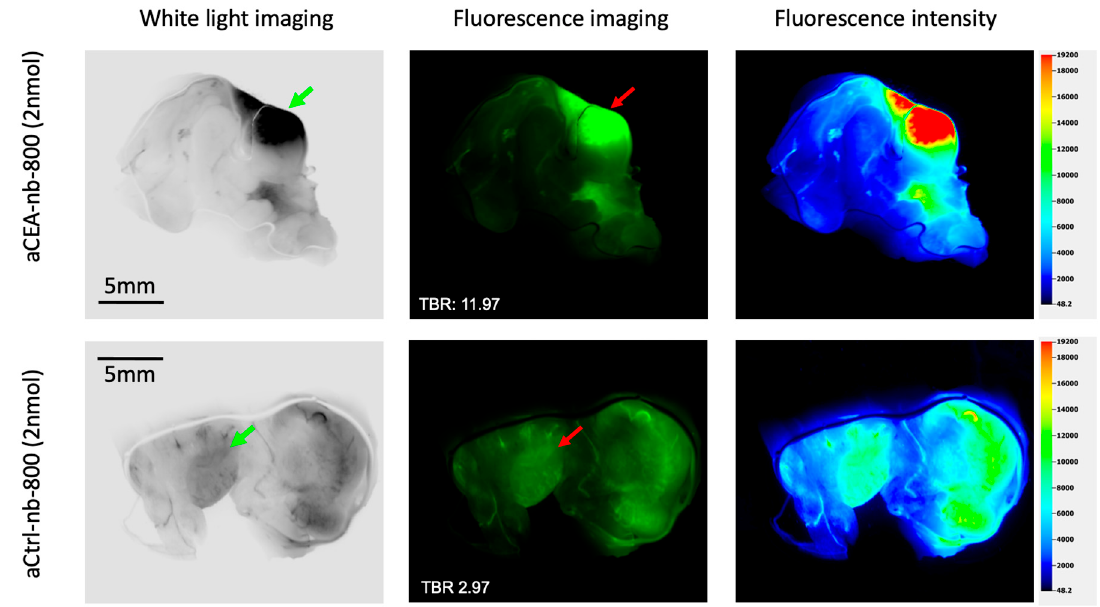
Figure 3. Pancreatic cancer orthotopic patient-derived xenograft labeled with either aCEA-nb-800 ( top panels) or aCtrl-nb-800 ( bottom panels), bivalved and imaged ex-vivo using the LICOR- Odyssey. Images were acquired under white light and fluorescence (800 nm) excitation sources. The fluorescence signal was localized at the tumor and did not show a signal at the surrounding pancreatic parenchyma. Under magnification, the tumor showed a TBR of 11.97 at the tumor using aCEA-nb-800 and a TBR of 2.97 using aCtrl-nb-800. Fluorescence intensity was mapped using the LICOR Image studio software to generate a color heat-ma.